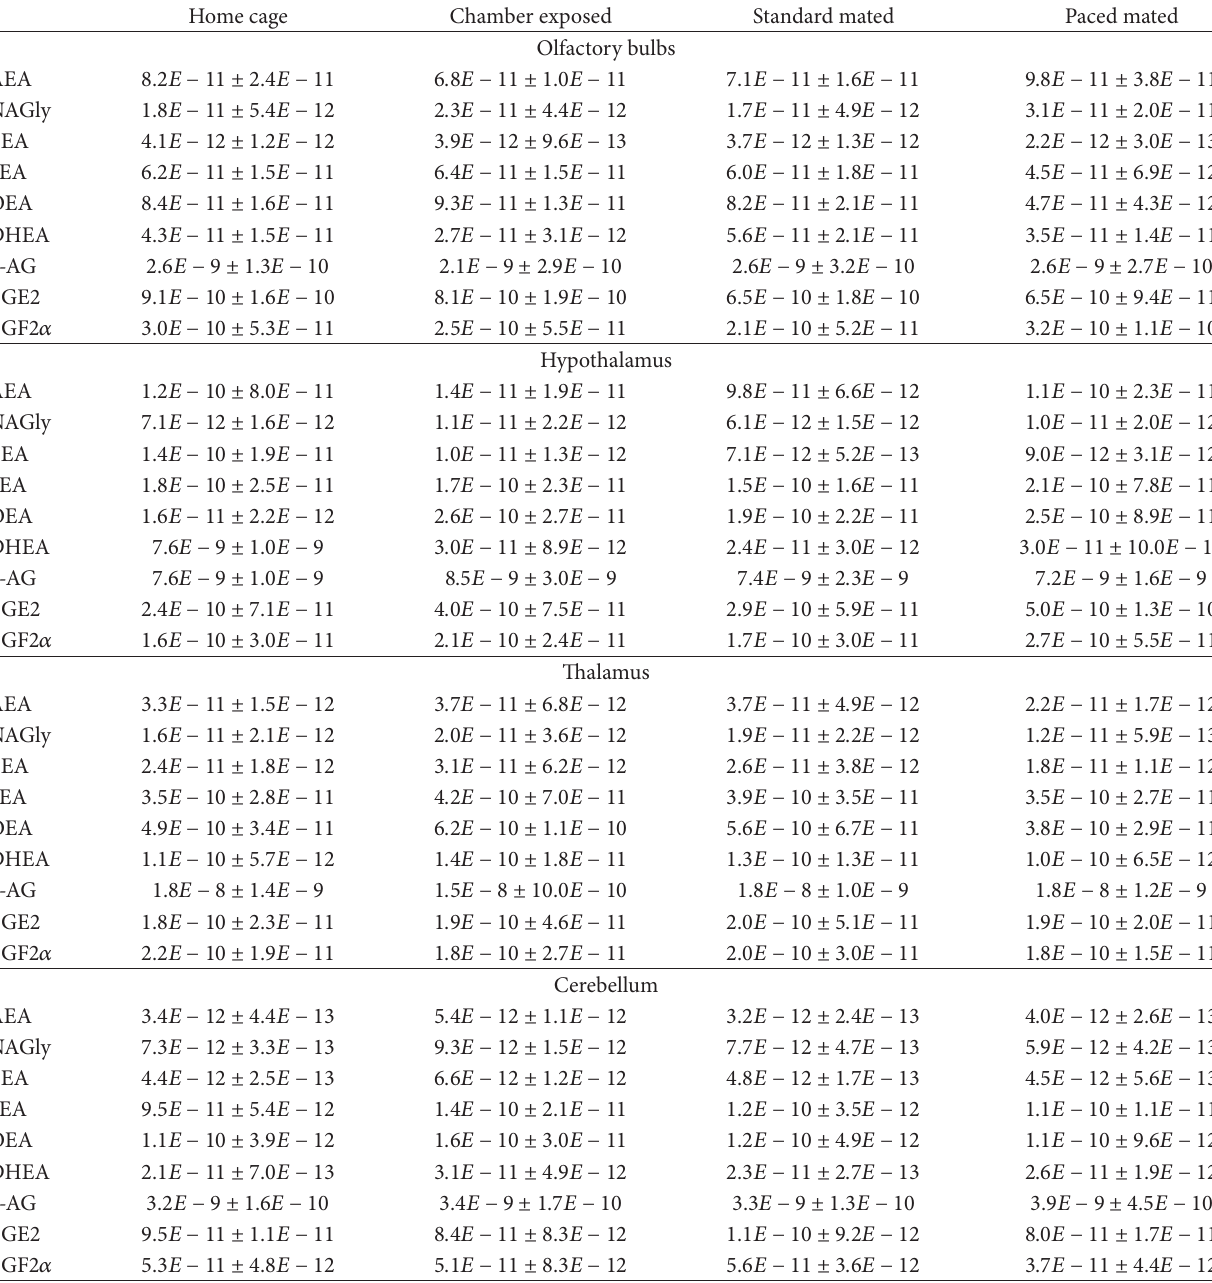
Table 2: Levels of lipid production in olfactory bulbs, hypothalamus, thalamus, and cerebellum across the four treatment groups: home cage control, chamber exposed, standard mated, and paced